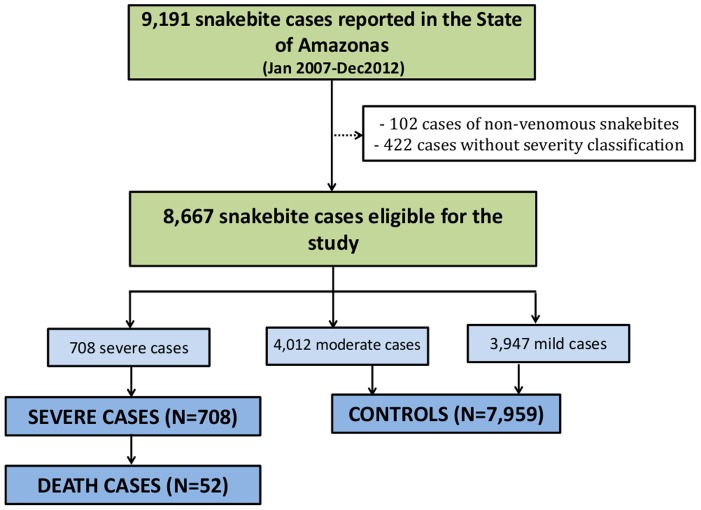
Flow chart of cases and control selection.The selection of cases and controls was based on the Brazilian Ministry of Health classification. All severe bites were included as cases, and three mild and moderate bites were in the control group for each case.